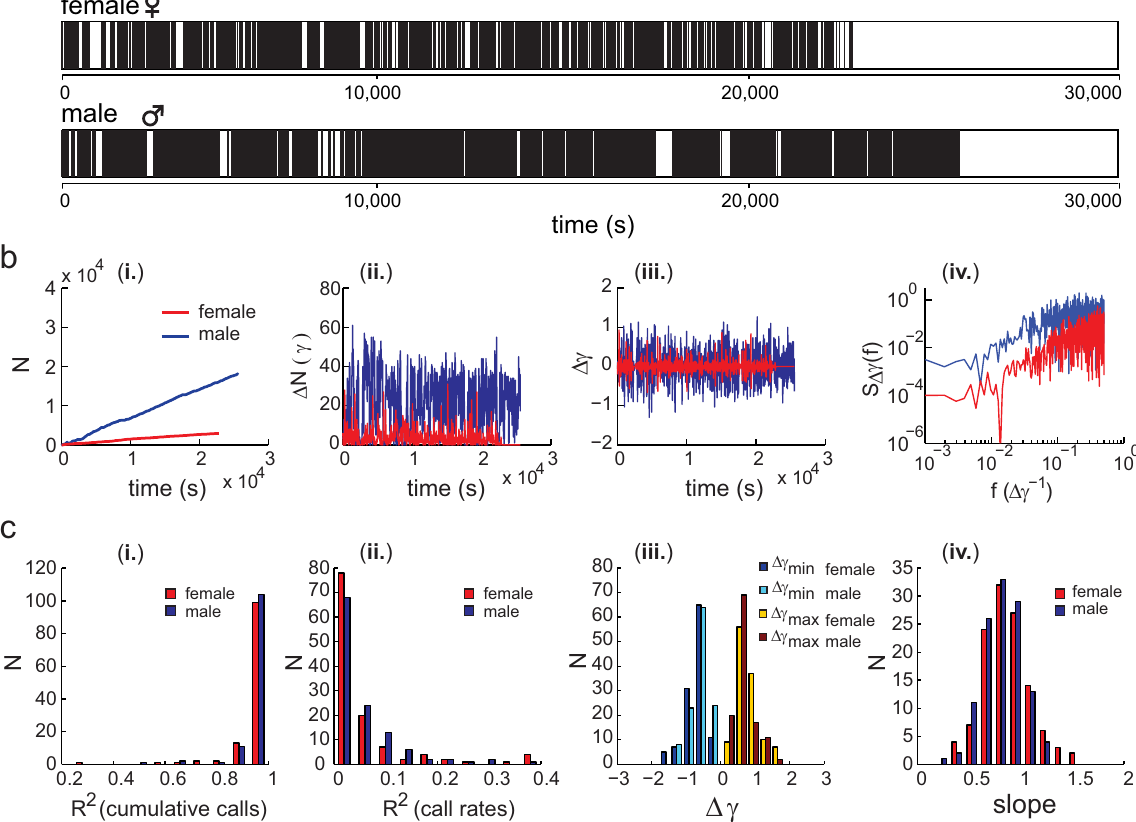
over a certain range of values ( τ ) will converge only if the range is between τ min and +∞ , whereas the integral of power-law function will diverge when the values ( τ ) are approaching 0. Taken together, we fitted our data over a range from τ min to the largest observed values. In contrast to power-law functions, the exponential functions are not constrained by a dynamic range. The exponential cumulative distribution functions (Exp CDF):